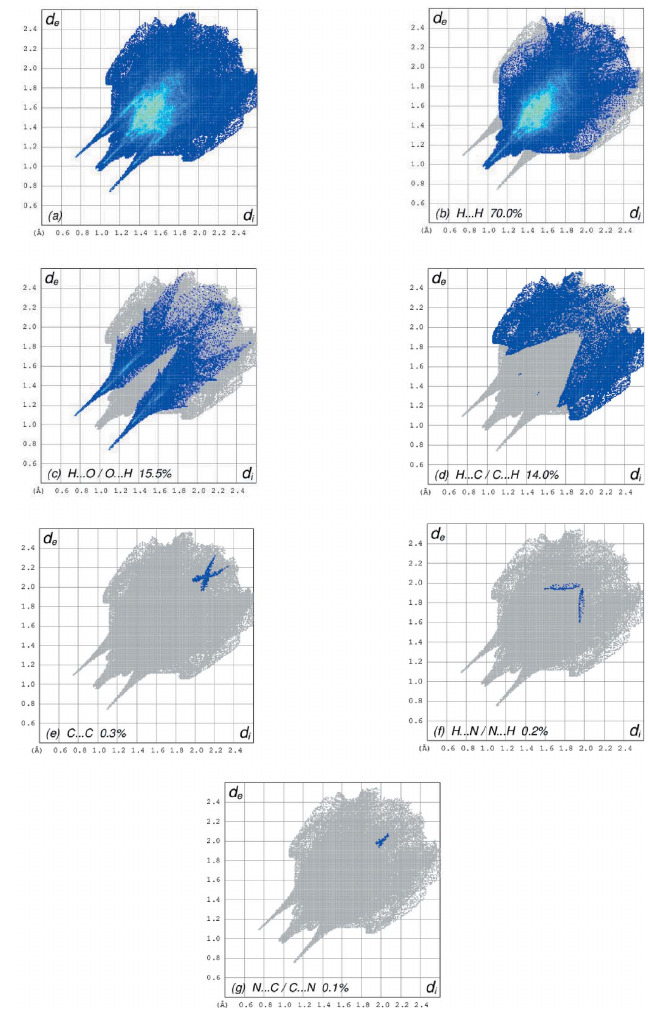
Figure 6 The full two-dimensional fingerprint plots for the title complex, showing ( a ) all interactions, and delineated into ( b ) H (cid:3)(cid:3)(cid:3) H, ( c ) H (cid:3)(cid:3)(cid:3) O/O (cid:3)(cid:3)(cid:3) H, ( d ) H (cid:3)(cid:3)(cid:3) C/C (cid:3)(cid:3)(cid:3) H, ( e ) C (cid:3)(cid:3)(cid:3) C, ( f ) H (cid:3)(cid:3)(cid:3) N/N (cid:3)(cid:3)(cid:3) H and ( g ) N (cid:3)(cid:3)(cid:3) C/C (cid:3)(cid:3)(cid:3) N inter- actions. The d i and d e values are the closest internal and external distances (in A˚ ) from given points on the Hirshfeld surface